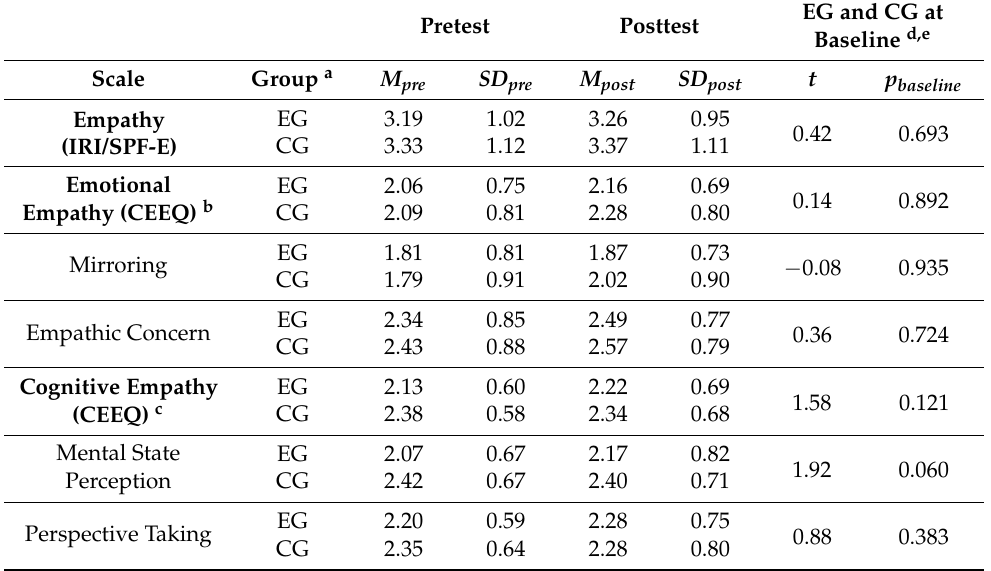
Table 2. Means and standard deviations of the measured main outcome variables and results of the t -test for independent samples at